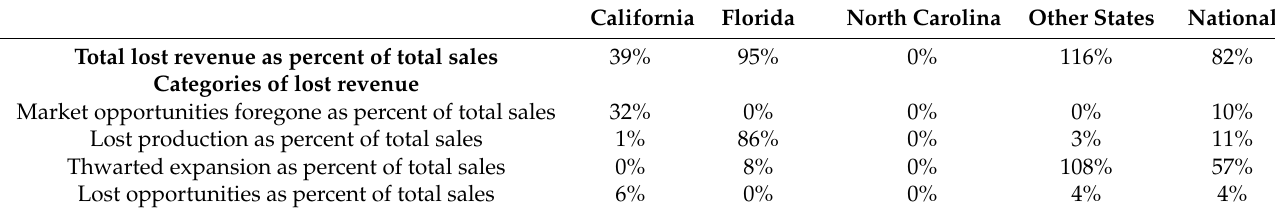
Table 13. Lost revenue as percentage of total sales.